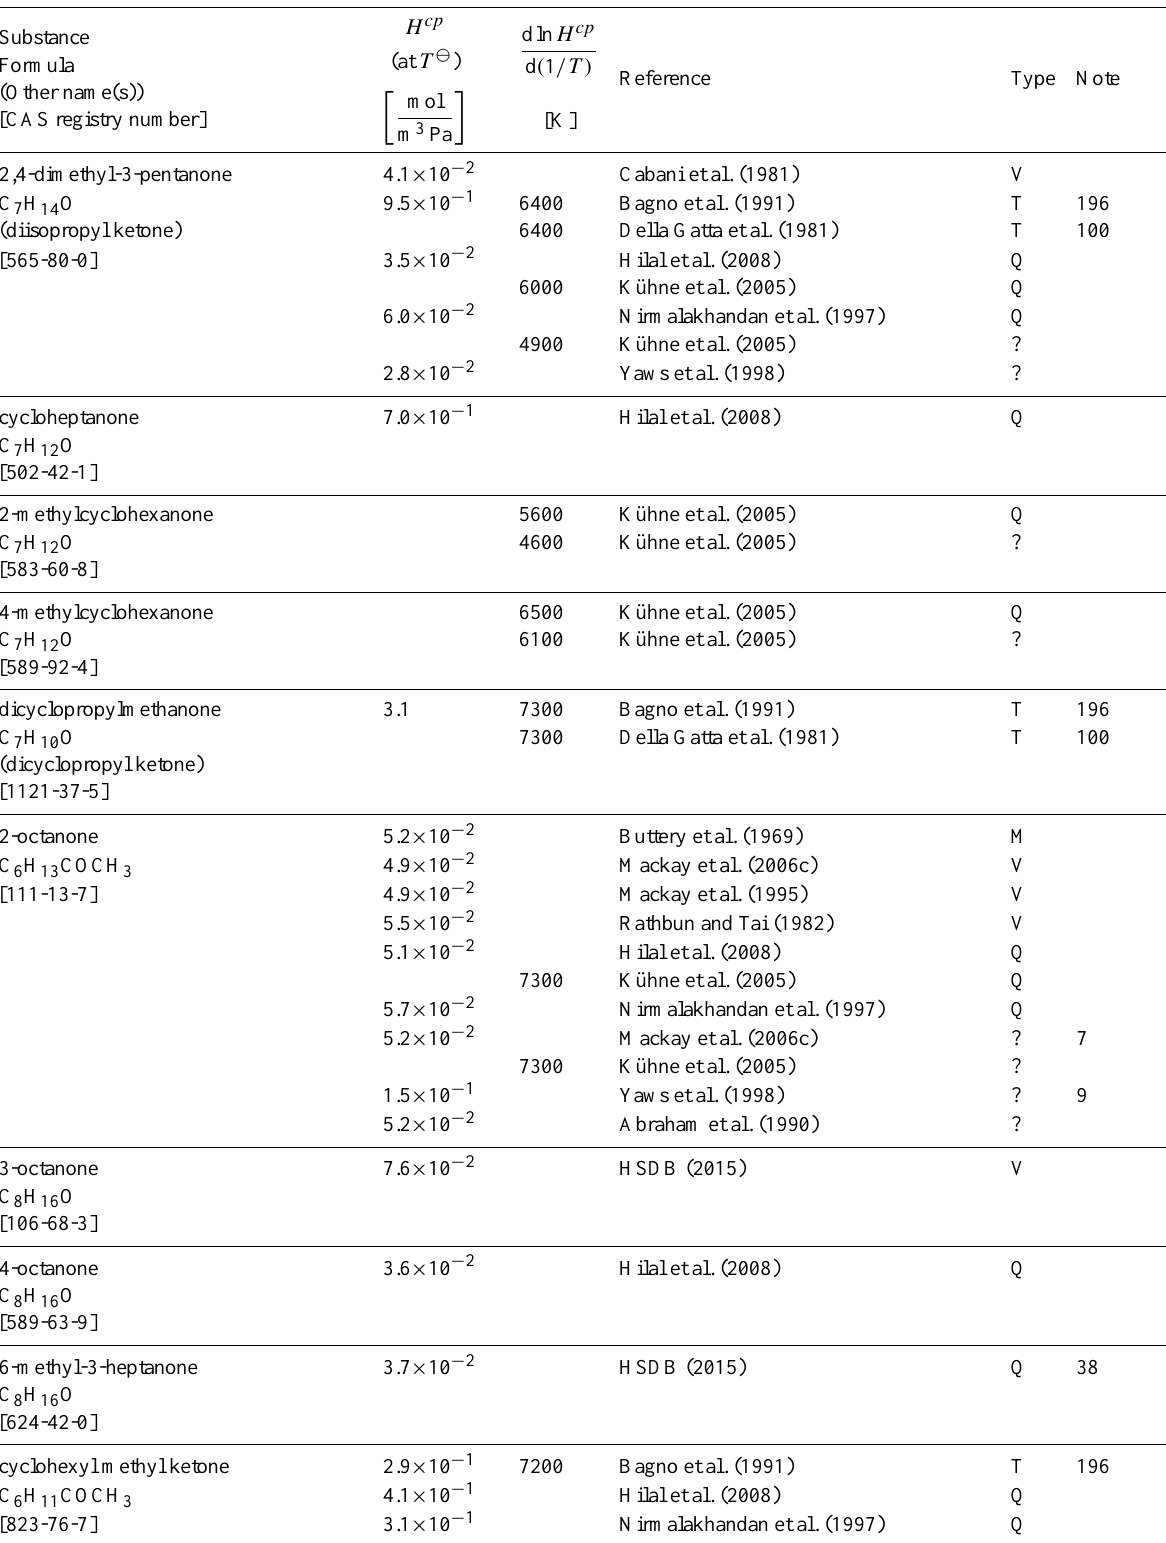
Table 6: Henry’s law constants for water as solvent